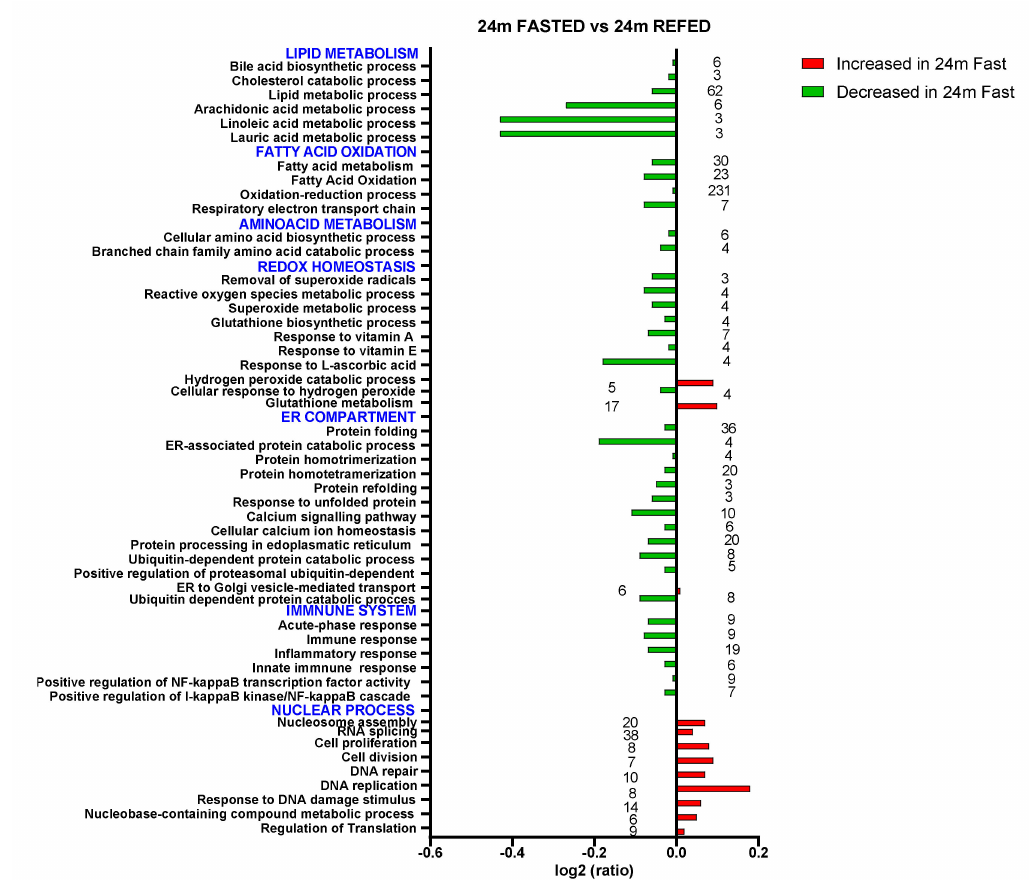
Figure 3. Biological processes and metabolic pathways affected in hepatic NEF of old rats upon refeeding after 36 h of fasting. Changing of biological processes (GOBPs) and metabolic pathways (KEGG and REACTOME) when comparing 24-month fasted vs. 24-month refed rats. The most representative GOBP and KEGG categories are shown indicating the number of identified proteins per categories. Data are presented as protein log2-ratios between the different experimental groups according to their estimated variances (z q values, see Supplementary Table S4). Red colors represent processes higher in 24-month fasted than in 24-month refed rats. Green colors represent processes lower in 24-month fasted than in 24-month refed